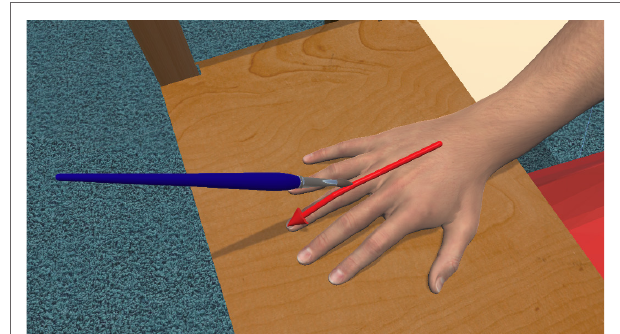
FigUre 3 | still figure of the visuotactile task, where participants saw a virtual brush stroking the virtual hand while the experimenter synchronously stroked their real hand . The path of the stroke for the D 3 virtual digit is displayed for illustrative purpose (red arrow), but was never presented to